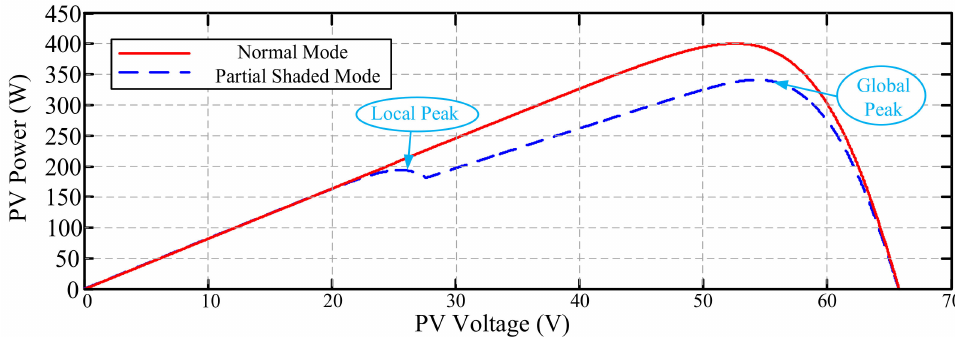
Figure 2. PV power curves for two modules at normal and partial shading